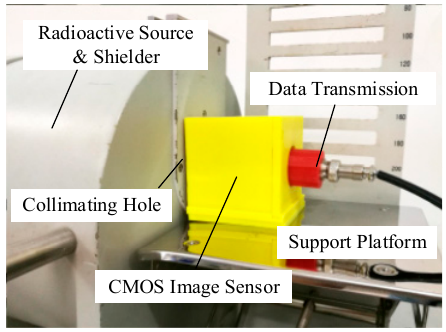
Figure 1. 137 Cs γ -ray source radiation experimental device.